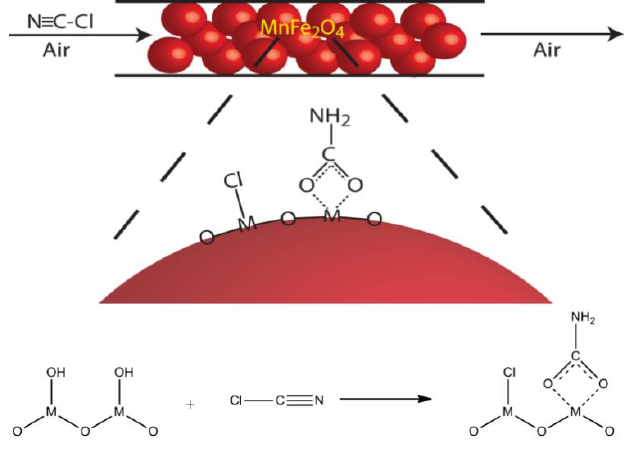
Figure 4. Mechanism of the surface reaction between CNCl and magnetic nanoparticles [61].